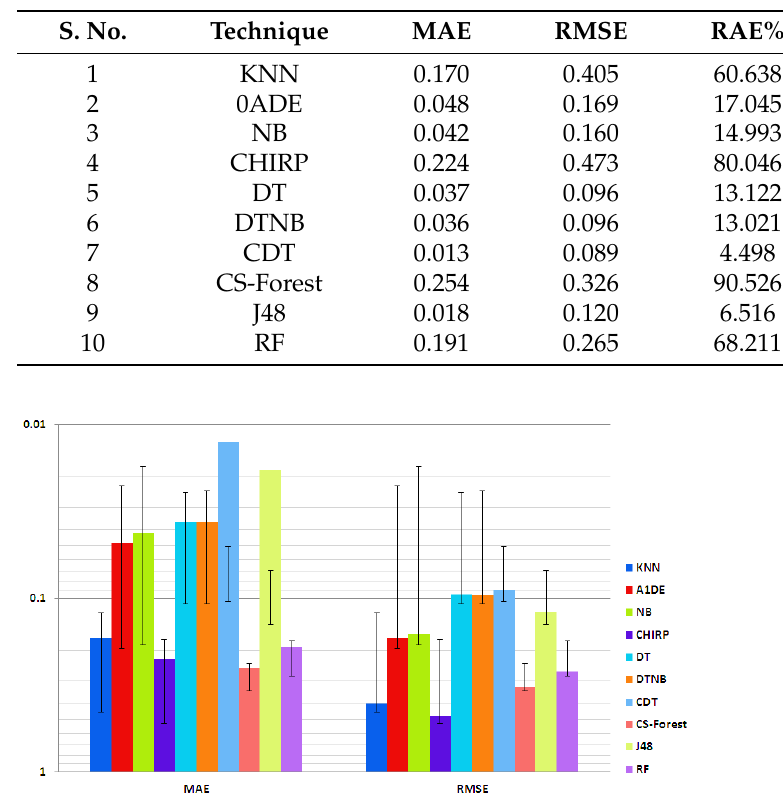
Figure 3. MAE and RMSE analysis of individual techniques along with SD